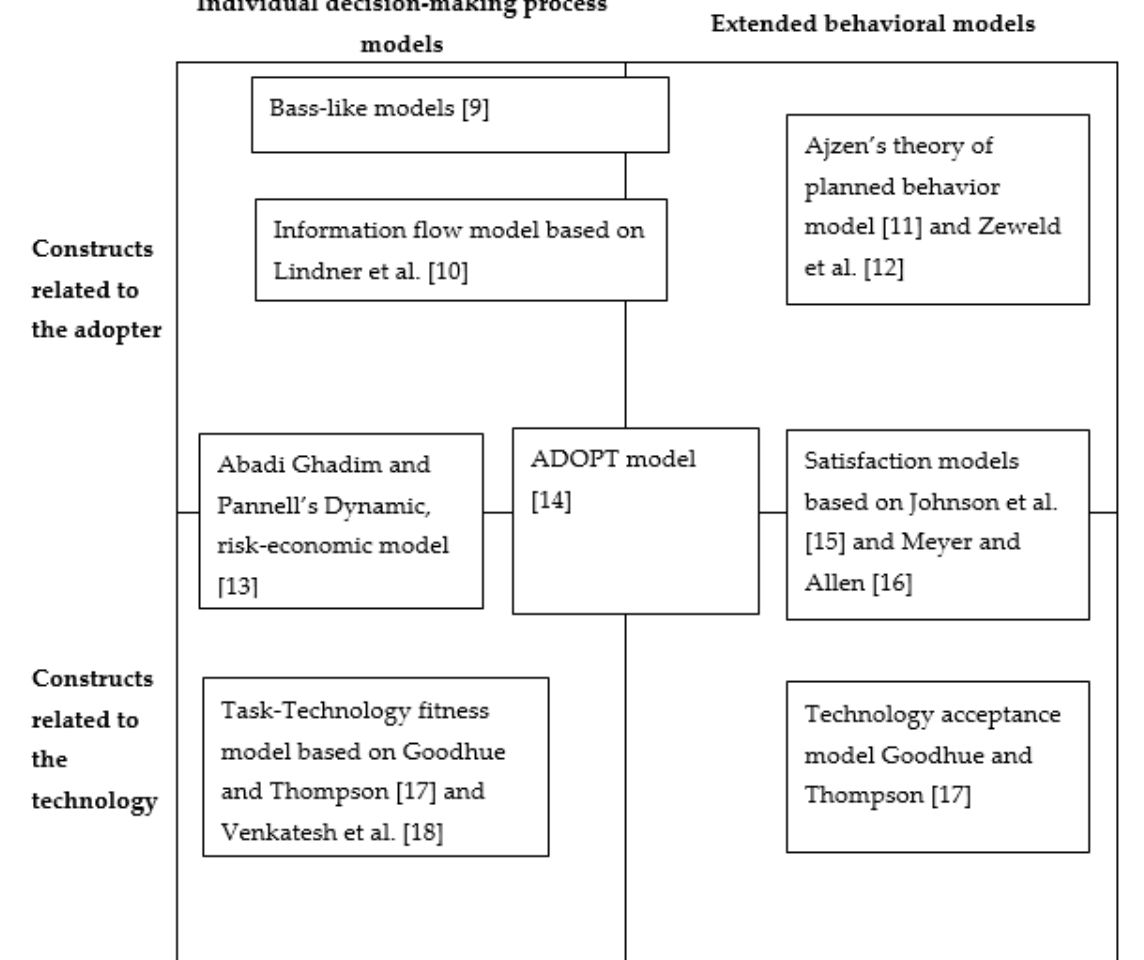
Figure 1. Conceptual models selected to illustrate a range of modeling approaches for adoption